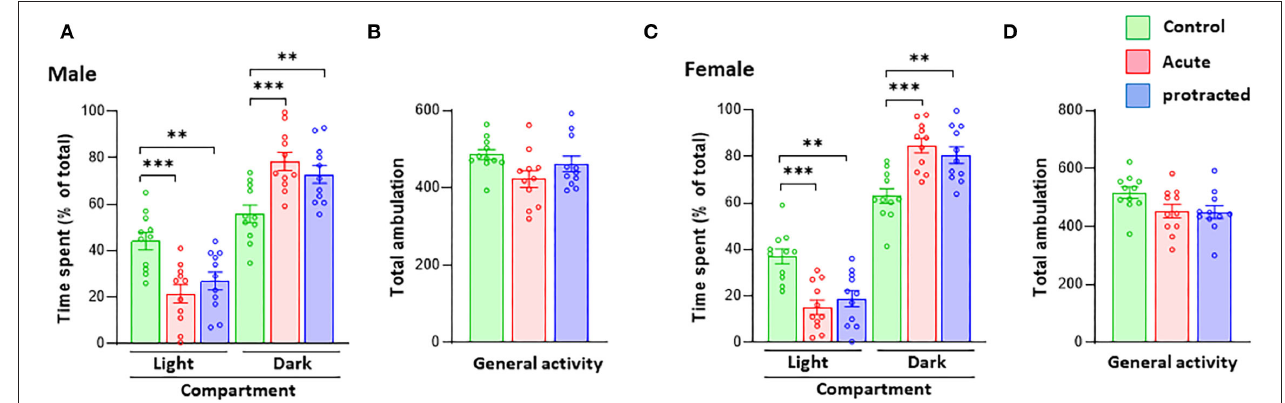
FIGURE 2 | Protracted and acute prenatal stress induces anxiety-like behaviors in young adult offspring at age of postnatal day 70 (PND70). Anxiety-like behaviors were measured using the LDB exploration test. In LDB test, compared with male and female progenies born form non-stressed dams, ones born from dam subjected to protracted or acute stress exhibited high preference to dark compartment in LDB test. (A,C) *** p < 0.001 Control vs. Acute, ** p < 0.01. There are no statistical differences between protracted and acute groups. All groups showed similar ambulation of LDB exploration (B,D) 1-way repeated ANOVA, n = 11 for each group). Values are the mean ± Standard Error of the Mean (SEM). Individual value is shown with circle dot on bar diagram.